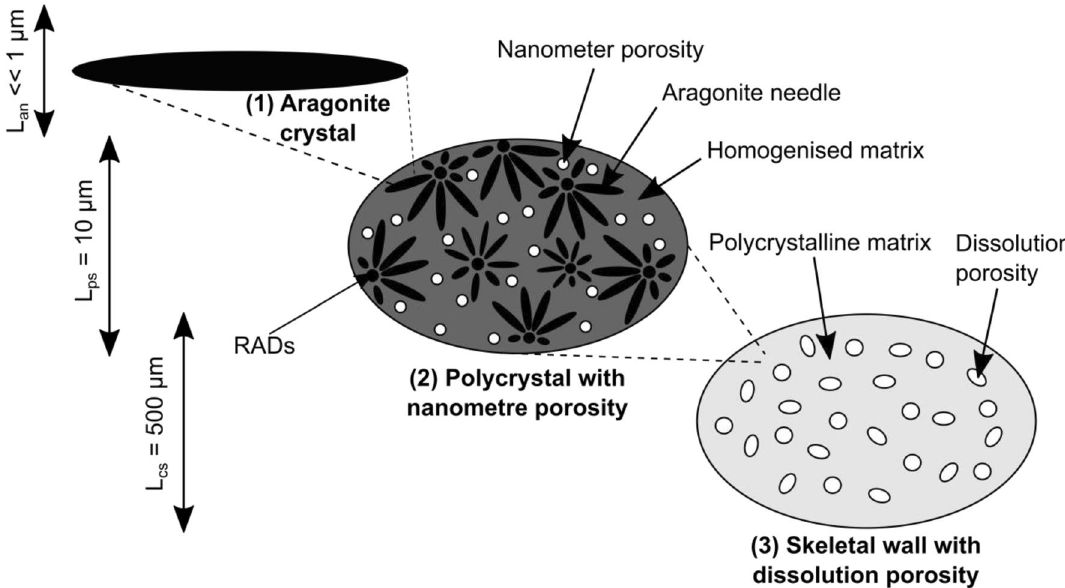
Figure 2. Multiscale model of the skeletal wall: The skeleton of L. pertusa consists of needle shaped aragonite crystals with finite aspect ratio. These needles are arranged around rapid accretion deposits and form a polycrystalline matrix which then forms the coral wall. This wall is subject to ocean acidification which generates spheroidal